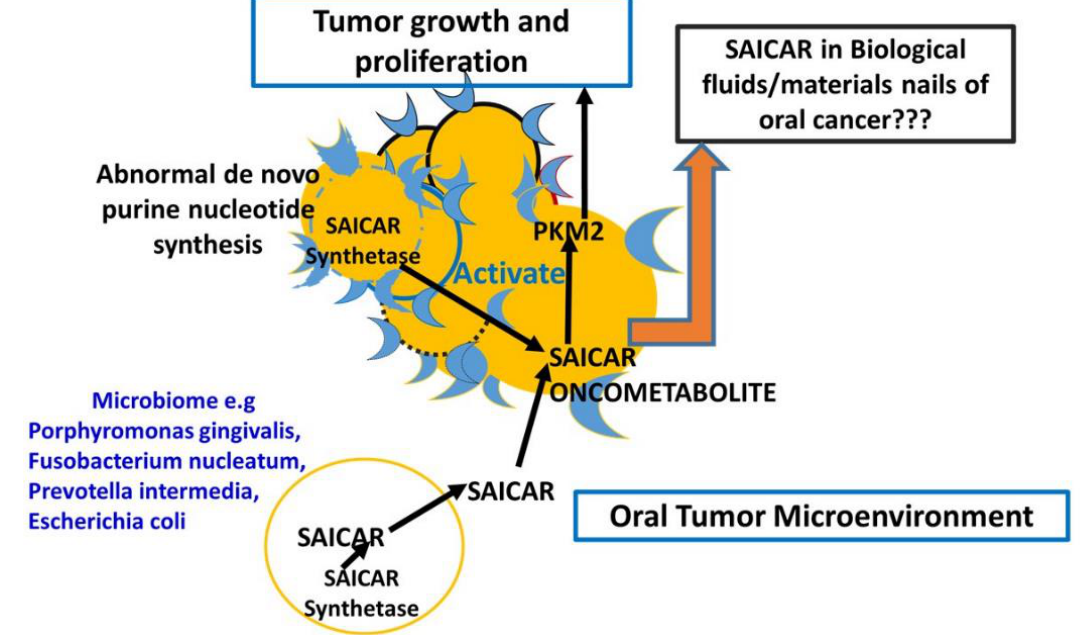
Figure 6. A proposed model on the role of SAICAR oncometabolite as a nail metabolite biomarker and predicted as a key metabolite in growth and proliferation by binding to PKM2.